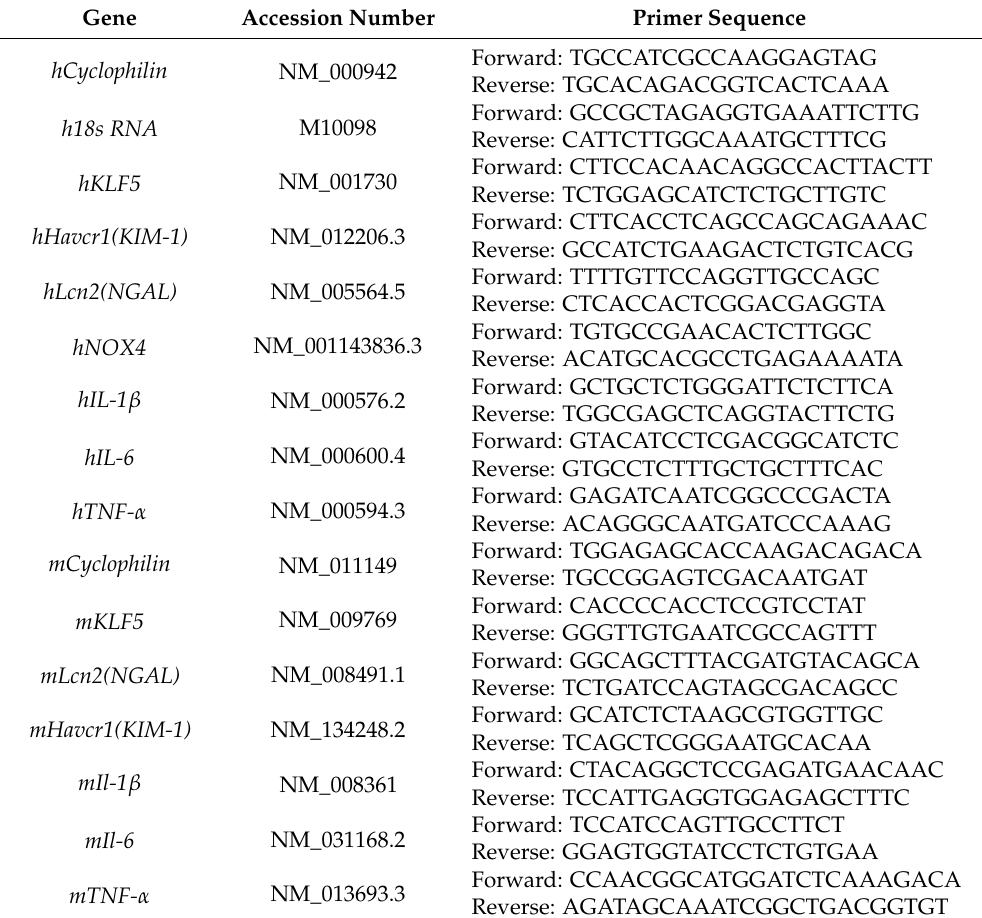
Table 1. Primer sequence (human (h) and mouse